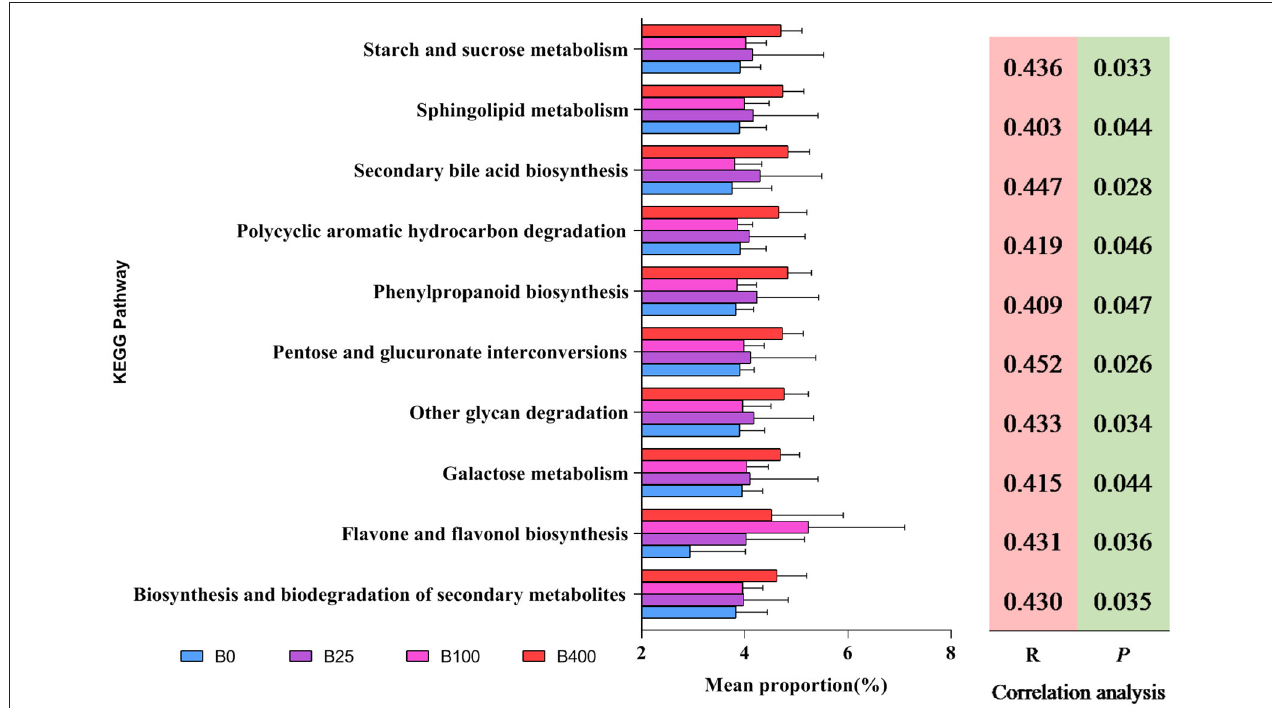
FIGURE 5 | The predicted metabolic attributes of cecal microbiota at genus level from different